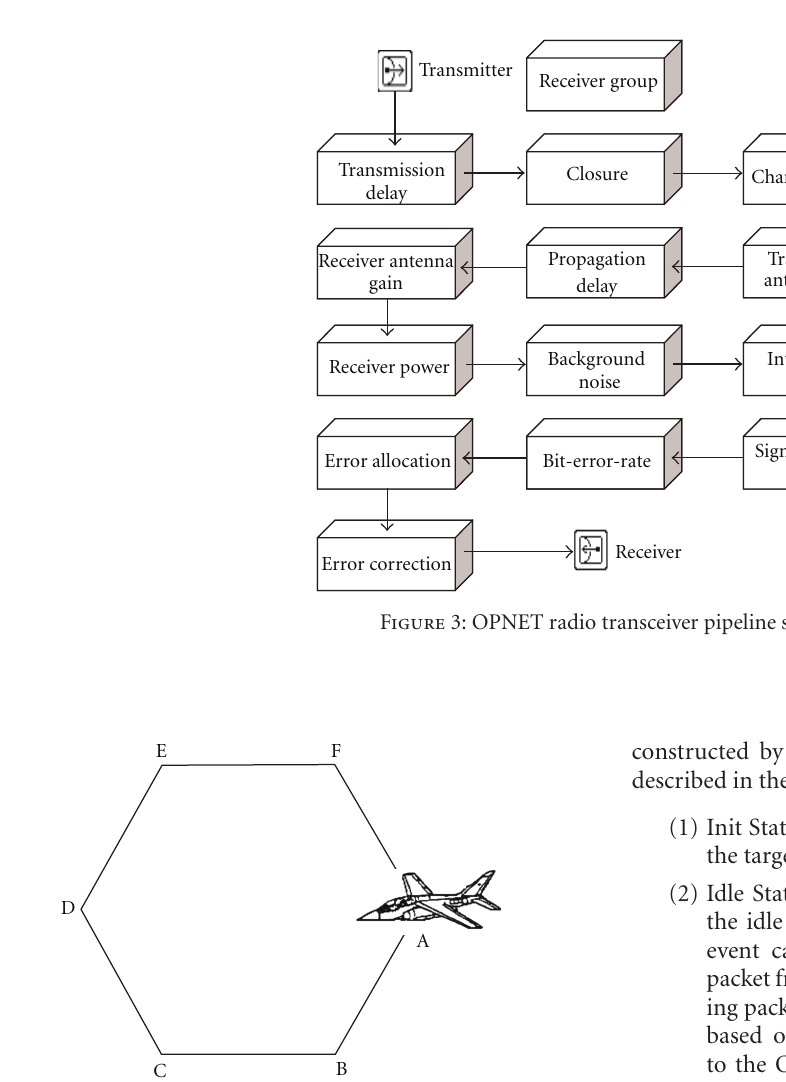
Figure 4: UAV mobility model in